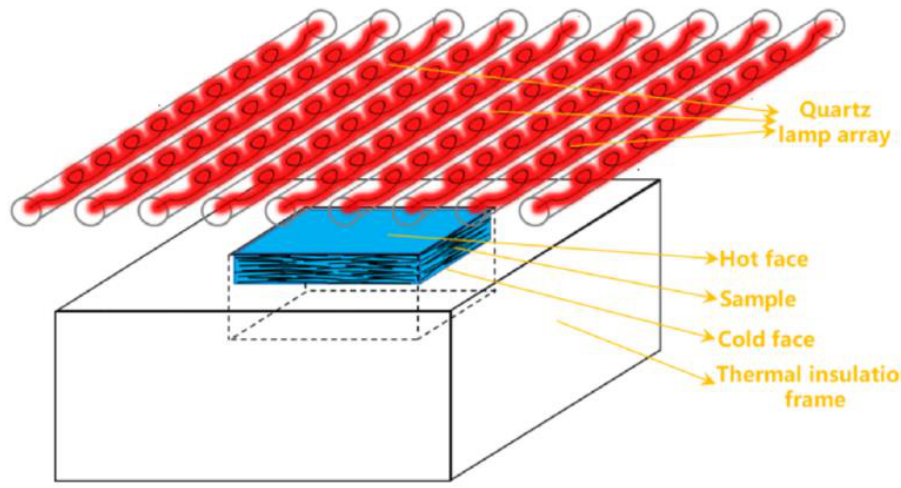
Figure 23. Schematic diagram of the quartz lamp heating test.